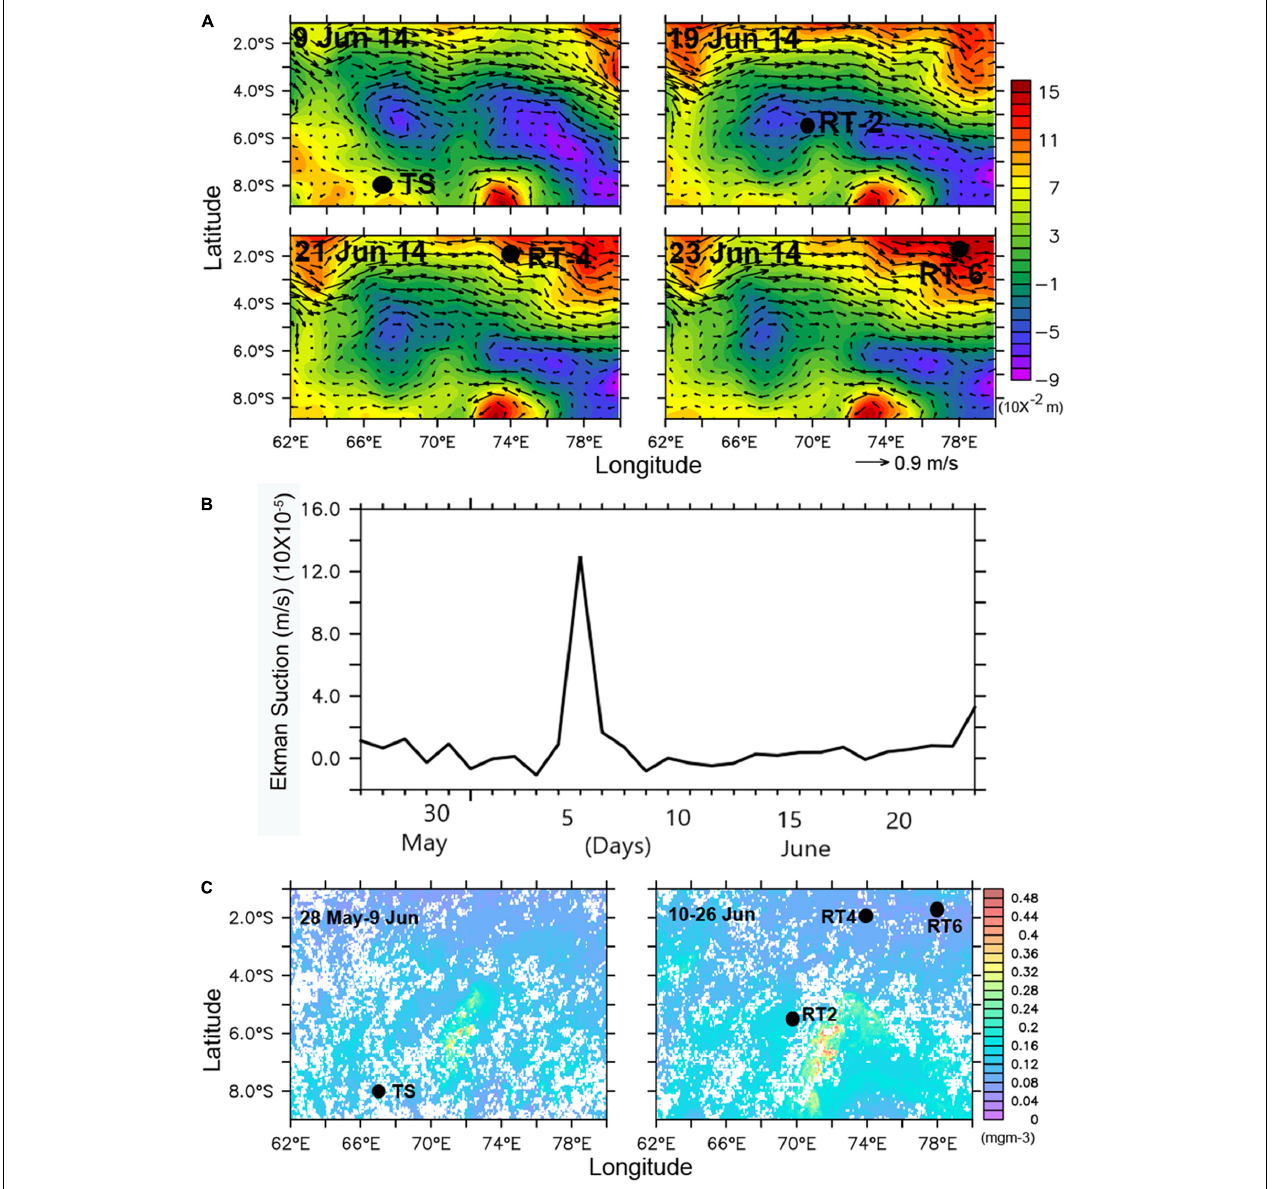
FIGURE 9 | (A) spatial distribution of sea surface height anomaly (SSHA) overlaid on geostrophic wind vectors (top right panel corresponds to RT-2, black dots denote the station locations), (B) average Ekman suction velocity at RT-2 region (6S:5S and 69E:70E) during May–June 2014 showing peak on 6 June, and (C) MODIS-Aqua derived weekly average level-3 chlorophyll images (black dots symbolizes station locations) indicating high chlorophyll-a patch at RT-2.